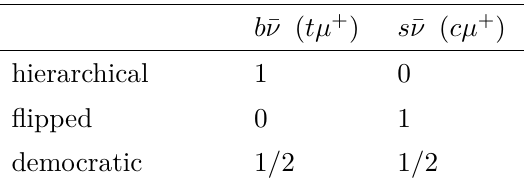
( V +5 / 3 ) leptoquarks in the benchmark scenarios from 3 3